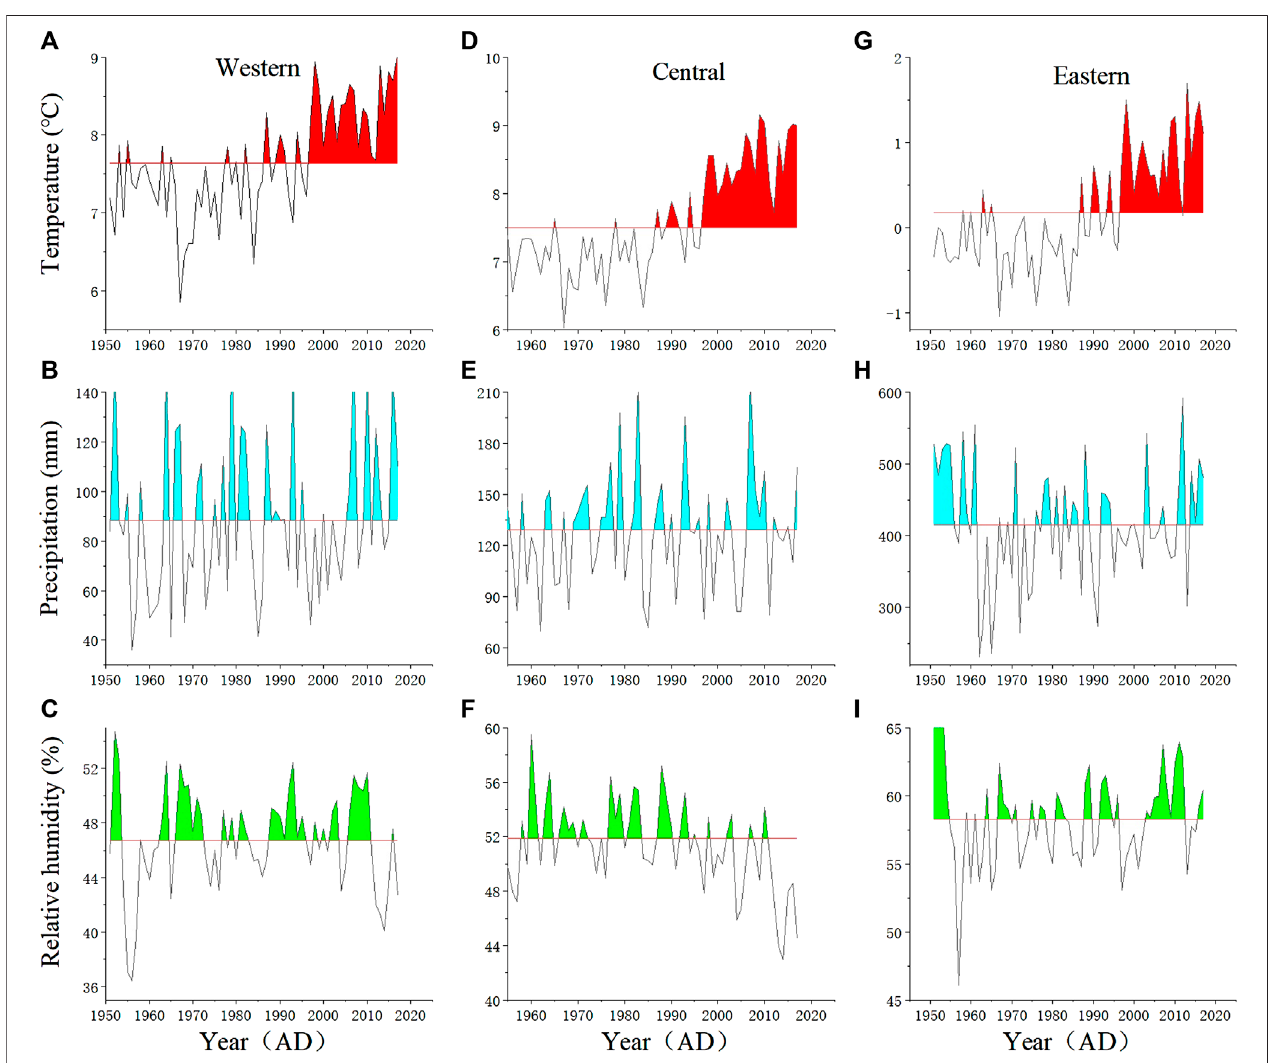
FIGURE6| Annualprecipitation(mm),annualaveragetemperature( ° C),andrelativehumidity(%)intheeastern,central,andwesternpartsofthenorthernslopesof the Qilian Mountains (data from China Meteorological Data Network http://data.cma.cn/). (A) Annual temperature at the Jiuquan Meteorological Station during 1951 – 2017. (B) Annual precipitation at Jiuquan. (C) Relative humidity at Jiuquan. (D) Annual temperature at the Zhangye Meteorological Station during 1951 – 2017. (E) AnnualprecipitationatZhangye. (F) RelativehumidityatZhangye. (G) AnnualtemperatureattheWushaolingMeteorologicalStationduring1951 – 2017. (H) Annual precipitation at Wushaoling. (I) Relative humidity at Wushaoling. Black horizontal lines represent the mean value.